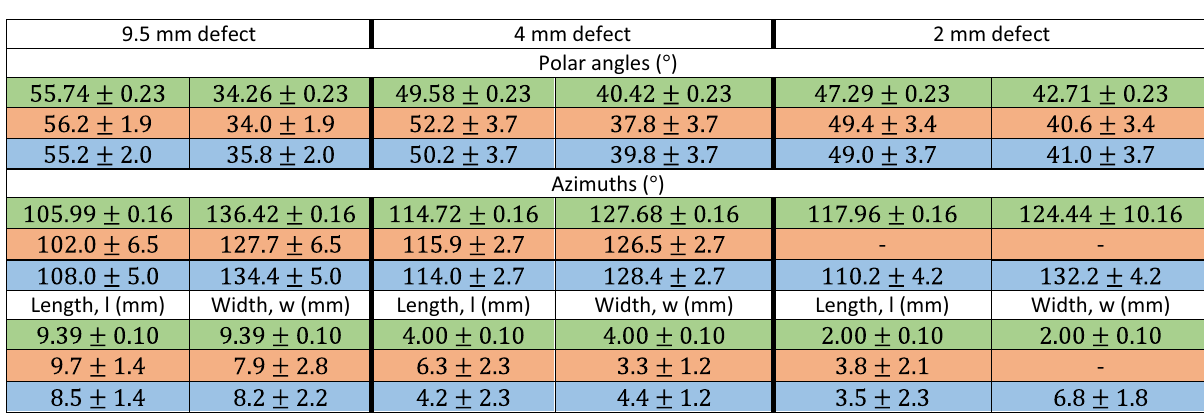
Table 1. Defect location and size in the true location, simulated, and experimental cases for the 9.5 mm, 4 mm and 2 mm holes. From top to bottom, expected (green), experimental (orange), and simulation results (blue). Length and width are the dimensions of the sector containing the defect along both, the azimuthal and polar directions (Fig. 1e). The azimuthal coordinates as well as the width for the 2 mm defect in the experimental case are missing since there was no visible shadowing of the acoustic waveforms by the cavity (Supplementary Fig. S3). The magnitudes feature confidence limits of one standard deviation. The corresponding uncertainty calculations are presented in the supplementary